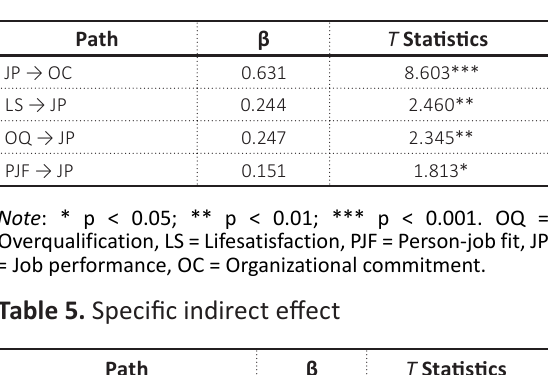
Table 4. Path coefficients